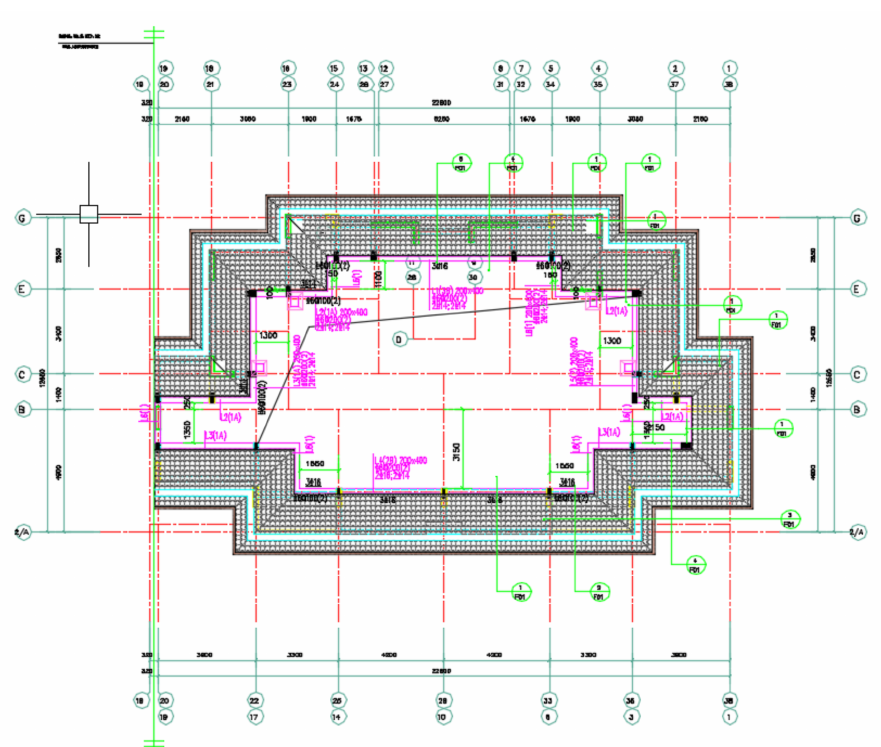
Figure 7. Roof renewal